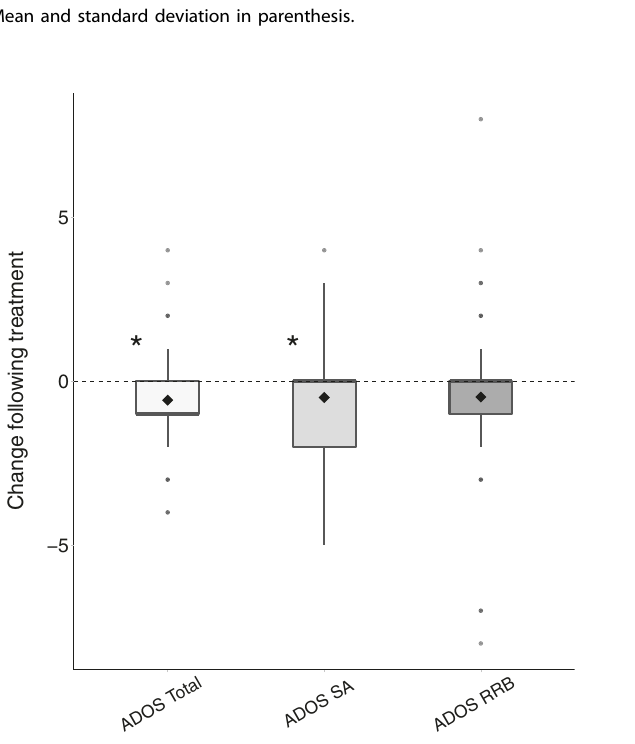
Fig. 1 Change in ADOS CSS following 6-month cannabis treat- ment. Box plot diagrams presenting distribution of changes in the total ADOS CSS (left) ADOS CSS SA (middle) and ADOS CSS RRB (right). Asterisk: signi fi cant change ( p < 0.05, randomization test). Black diamond: mean. Bold line: